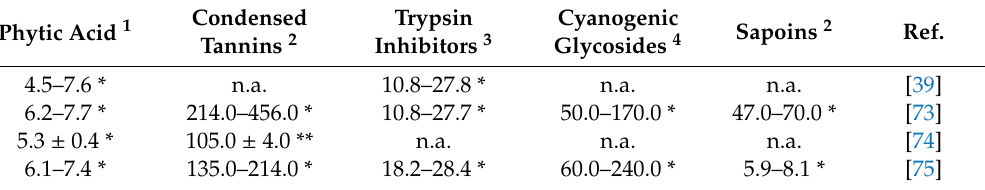
Table 8. Hempseed antinutritional